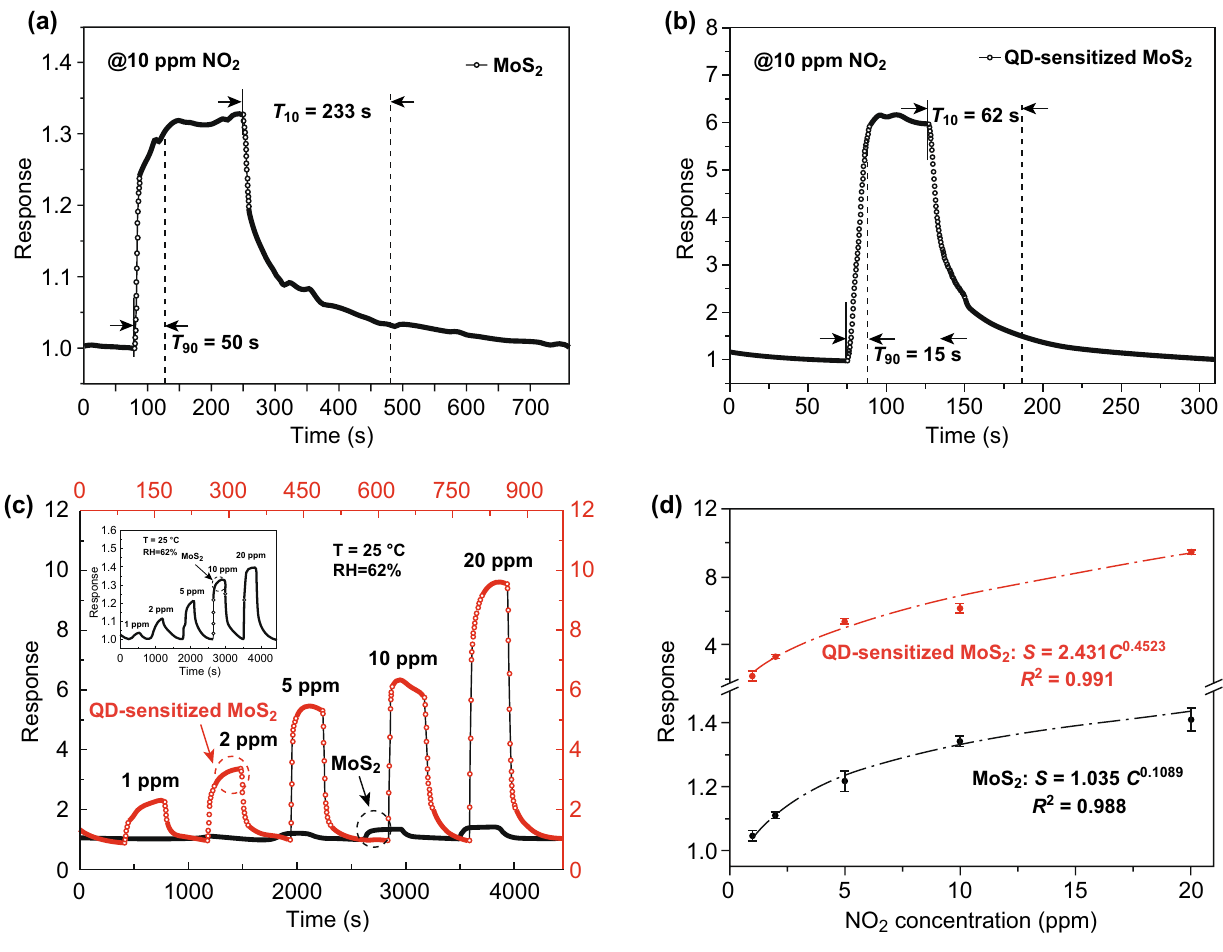
Fig. 4 Time‑resolved response and recovery curves of a MoS 2 nanosheets and b the sensitized MoS 2 gas sensors exposed to 10 ppm NO 2 at room temperature. c Transient relative response of both sensors toward different NO 2 concentrations. d The relative response versus the NO 2 concentration illustration of the MoS 2 and the sensitized MoS 2